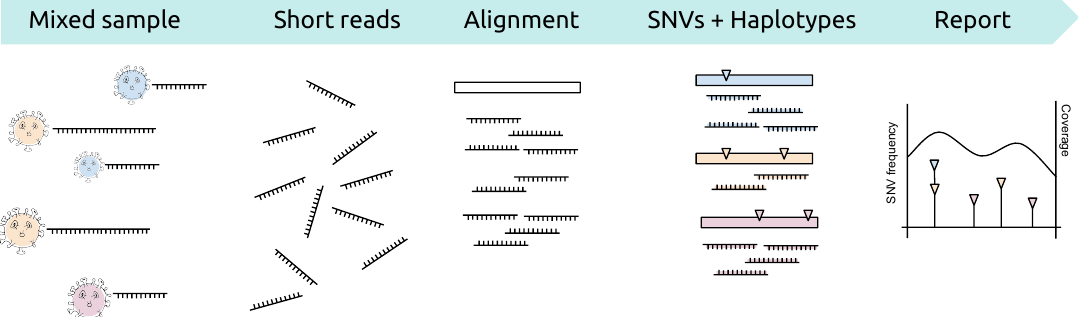
Figure 4. Basic workflow of V-pipe for end-to-end analysis of viral NGS data. Starting from a heterogeneous virus population, amplification and sequencing will produce a set of sequencing reads, each derived from one of the molecules in the original mixed sample. Reads are aligned, possibly with the help of a reference genome, and filtered according to various quality control criteria. From the multiple alignment of all reads, genetic variants are called either position-wise (single-nucleotide variants, SNVs) or for longer genomic regions (viral haplotype reconstruction). The results, including all SNVs and their estimated frequencies in the virus population, are summarized and visualized in an electronic interactive